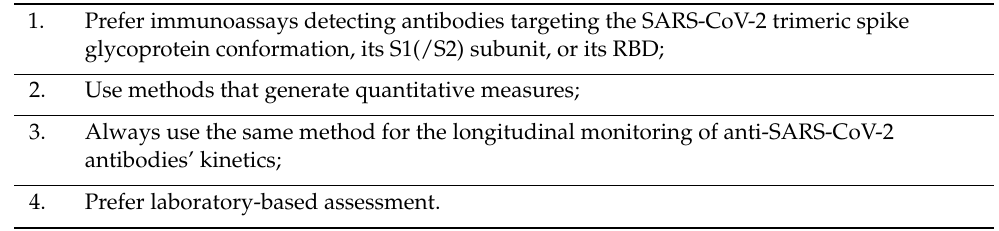
Table 3. Technical and logistic consideration for serological testing in recipients of COVID-19